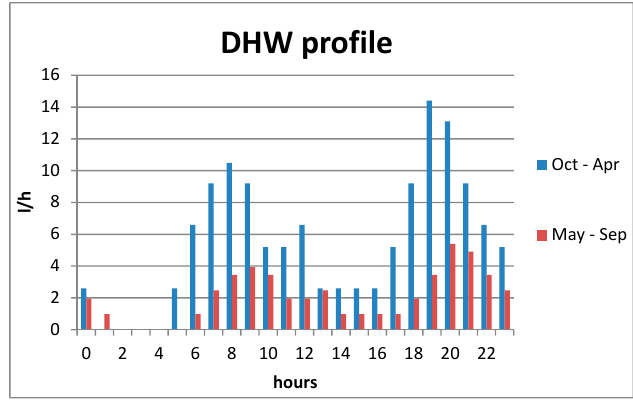
Figure 4. Domestic hot water daily schedule along the year [28].